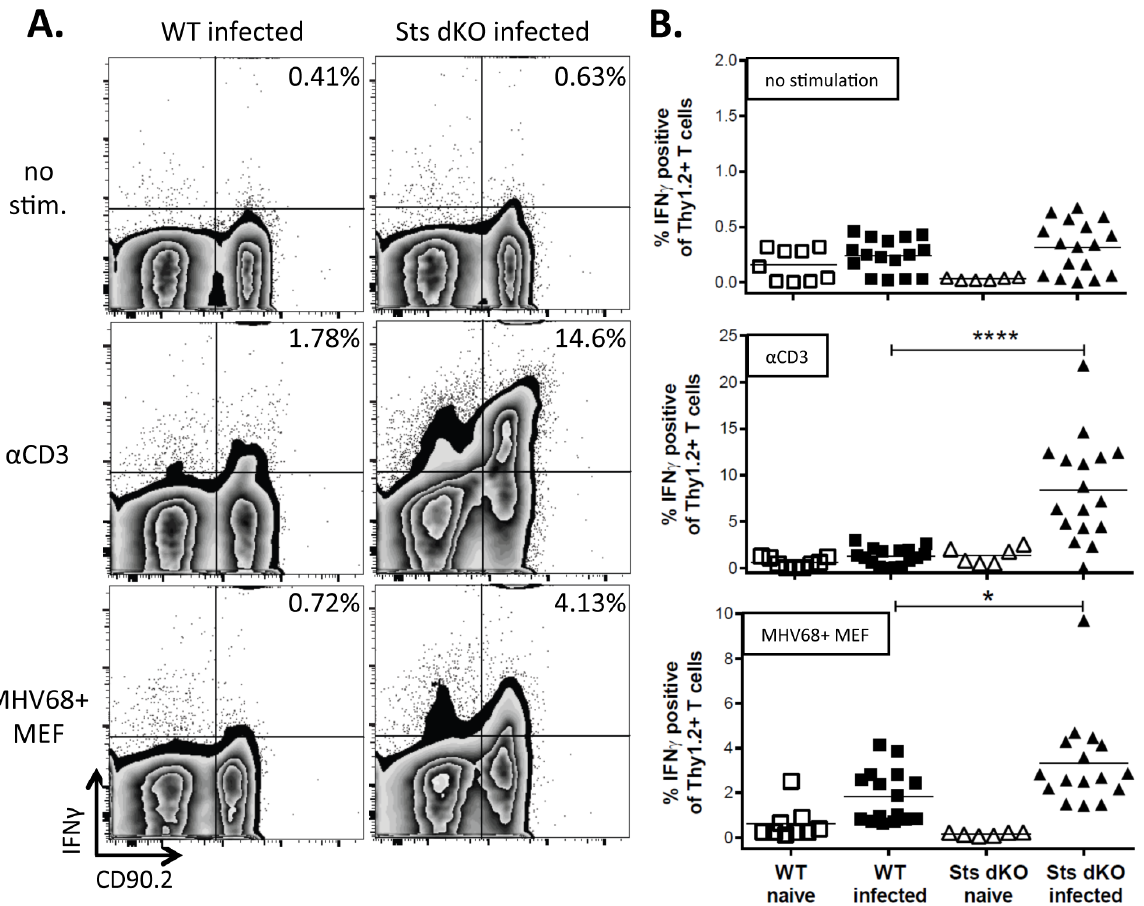
Figure 1. Increased IFN c response to infected cells in the absence of Sts1 and Sts2. Sts dKO and C57BL/6 WT mice were infected 1000 PFU of MHV68 by the intranasal route and spleens were harvested 28 dpi. Splenocytes were left untreated or stimulated with 1 ug/ml a CD3 antibody or cocultured with gamma-irradiated MHV68-infected MEFs, both overnight in the presence of monensin. Cells were stained with the T cell marker CD90.2 and the intracellular cytokine IFN c and analyzed by flow cytometry. (A) Representative flow plots of IFN c expression in cells stained for CD90.2 are shown for each genotype and culture condition. (B) Scatter plot summary of the percentage of T cells producing IFN c + after overnight stimulation. Symbols represent data from individual mice. *=p , .05, **** =p ,